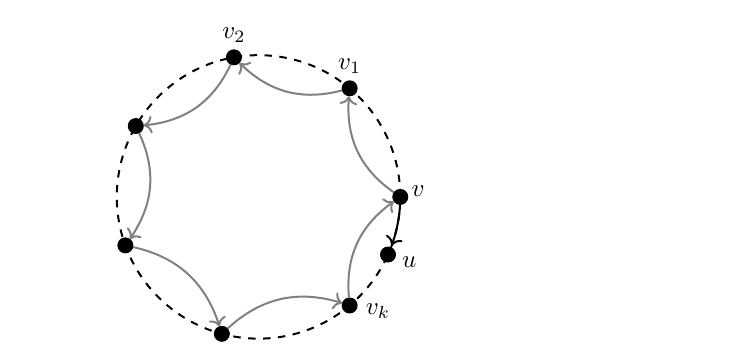
Figure 1: A minimum cover tour T from u to v is depicted by a dashed line, moving in clockwise direction. The edge vu is included to depict the closed walk T (cid:48) = T + vu . The grey arrows indicate the closed walk W , which visits all vertices in U , in counterclockwise